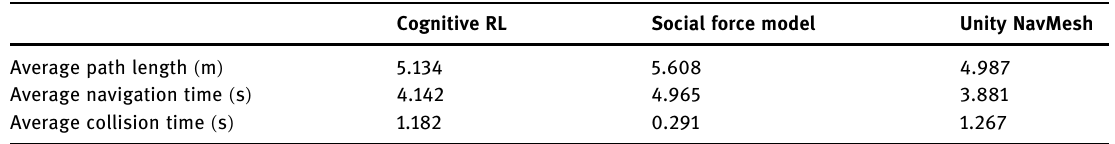
Table 3: Comparisons with social force model and unity NavMesh in average length, time and